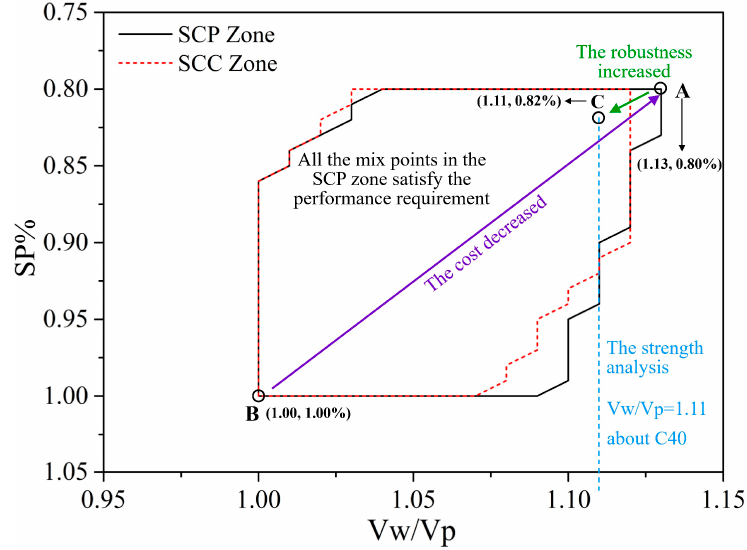
Figure 13. The performance-based mix design of series 3.